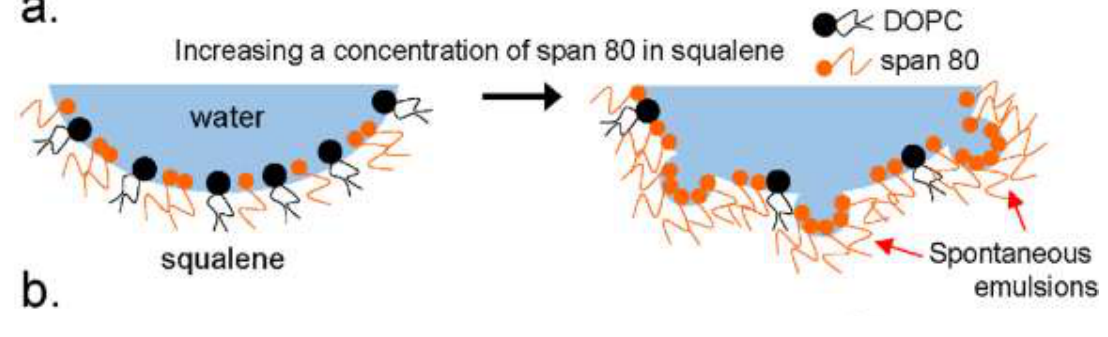
Figure 7: The structure of emulsion formed as DOPC/Span 80 act as surfactant